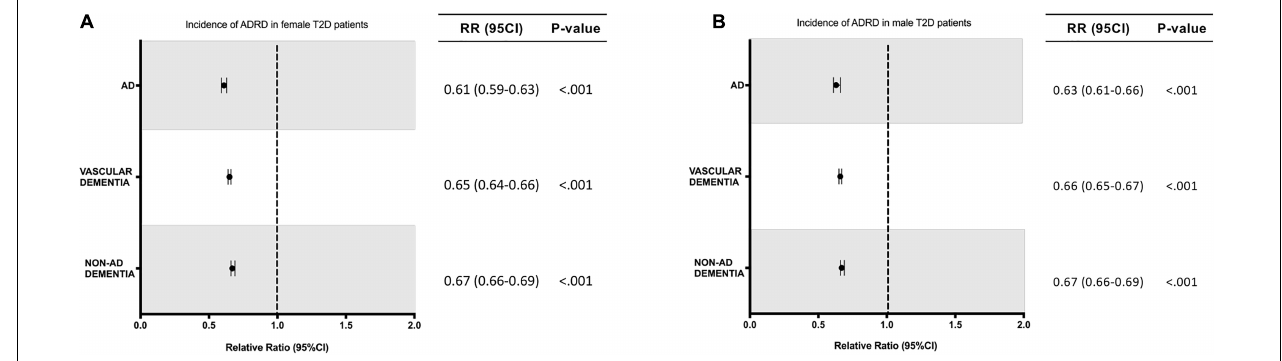
FIGURE 3 | Relative risk of developing AD or ADRD for T2D women and men with exposure to anti-hyperglycemic medication. (A) Relative risk for T2D female patients. (B) Relative risk for T2D male patients. ADRD, Alzheimer’s disease related dementias; AD, Alzheimer’s disease; RR, relative risk; CI, confidence interval.